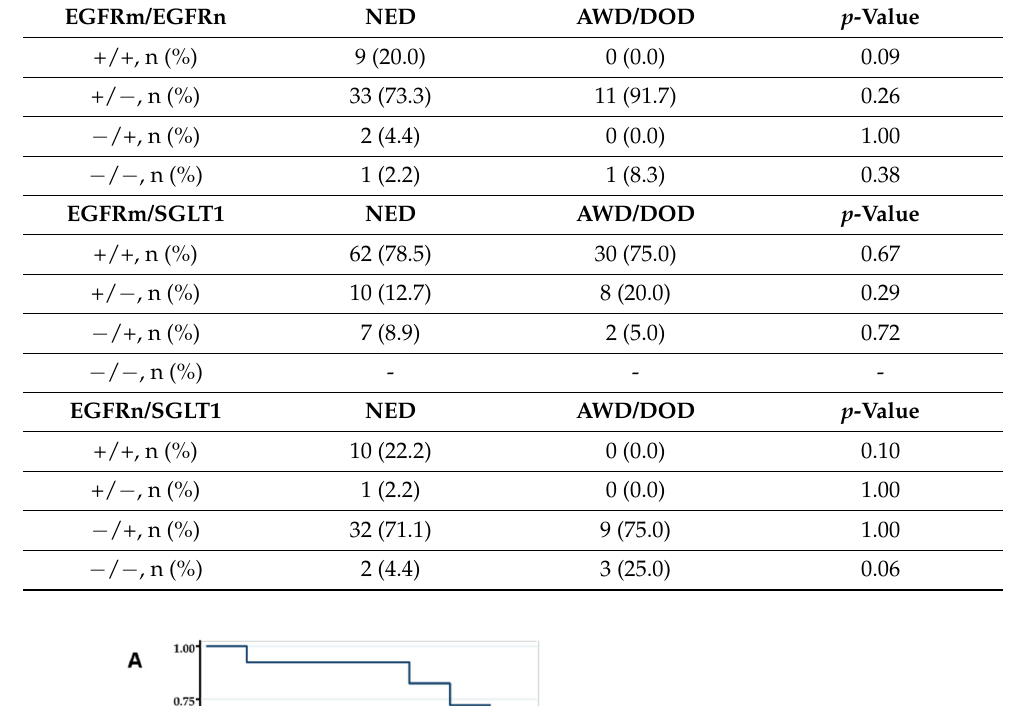
Table 6. Correlation between membranous EGFR, nuclear EGFR and SGLT1 expression levels combination and CCRCC patients with NED, AWD or DOD.